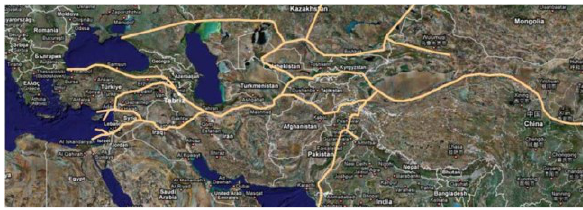
Figure 10 . The Location of Tabriz on the Silk Roads in Antiquity from 2nd Century B.C. to 4th Century A.D. (UNESCO, 2009).